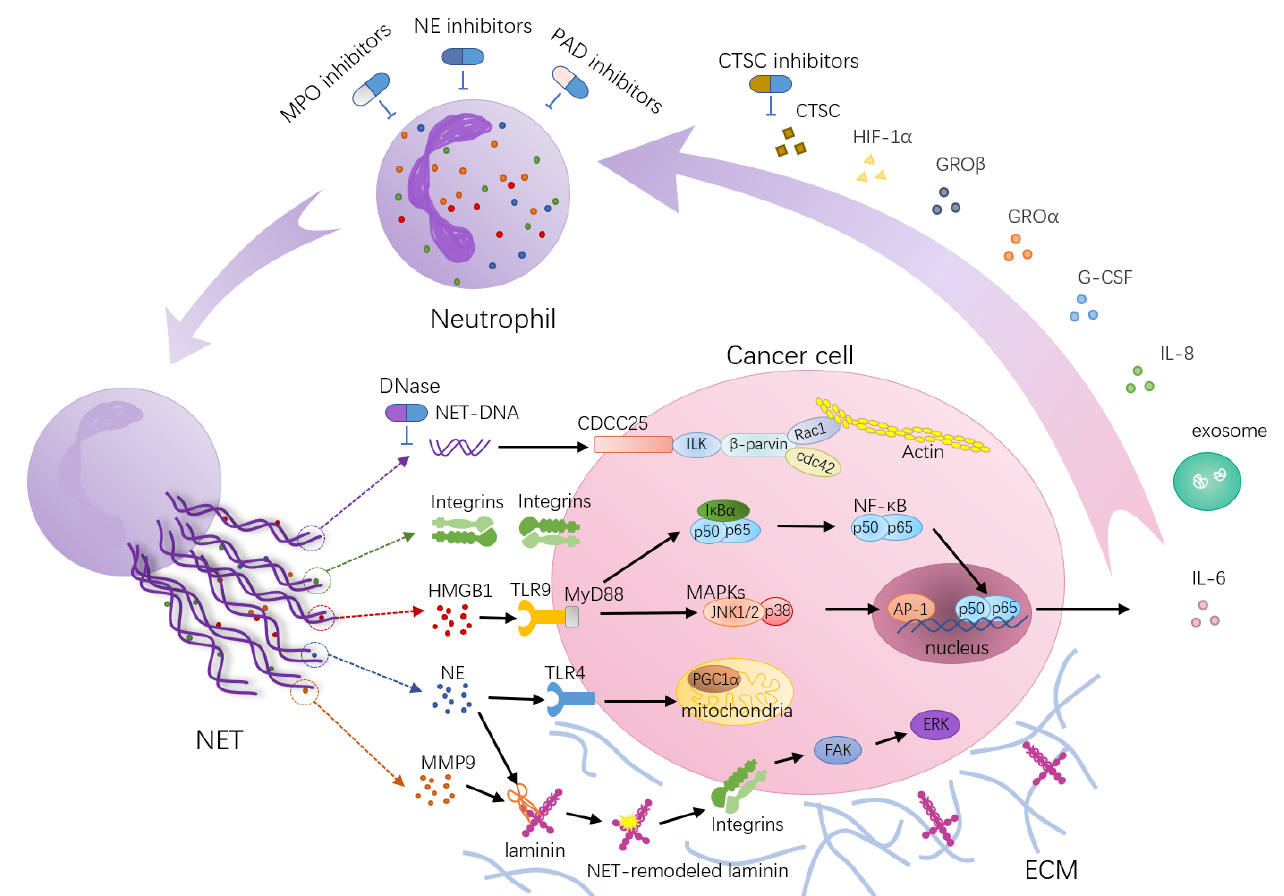
Figure 1. Neutrophil extracellular trap (NET)-associated molecular mechanisms’ function in tumor metastasis. NETs act as scaffolds mediating the capture of cancer cells and providing a microenvironment that can bring protumorigenic proteins close to cancer cells. HMGB1, a highly conserved DNA binding protein, is one of the components of NETs. NETs trigger HMGB1 release and activate TLR9-dependent pathways in cancer cells. The tumorigenic effects of TLR9 depend on NF- κ B- mediated upregulation of IL-6 expression and activation of a cascade of intracellular growth signaling pathways, including MAP kinase pathways. NE released from NETs activates TLR-4 on cancer cells, leading to PGC-1 α upregulation, increased mitochondrial biogenesis and accelerated growth. NETs trap circulating tumor cells via β 1-integrin-mediated interactions. NE and MMP-9 sequentially cut laminin, an important component of the ECM, revealing an epitope that triggers the proliferation of dormant cancer cells through integrin activation and FAK/ERK/MLCK/YAP signaling. Furthermore, the transmembrane protein CCDC25 is a NET DNA receptor on cancer cells that senses extracellular DNA and subsequently activates the ILK- β -parvin pathway to enhance cell motility. In turn, certain factors secreted by many primary tumors have been shown to promote NET formation, such as cytokines (HIF-1 α , IL-8, G-CSF, GRO α , GRO β ), proteases (CTSCs) and exosomes. During these processes, targets for therapies have been postulated, and interfering drugs (blue arrows) have already been used in clinical practice or are under investigation in